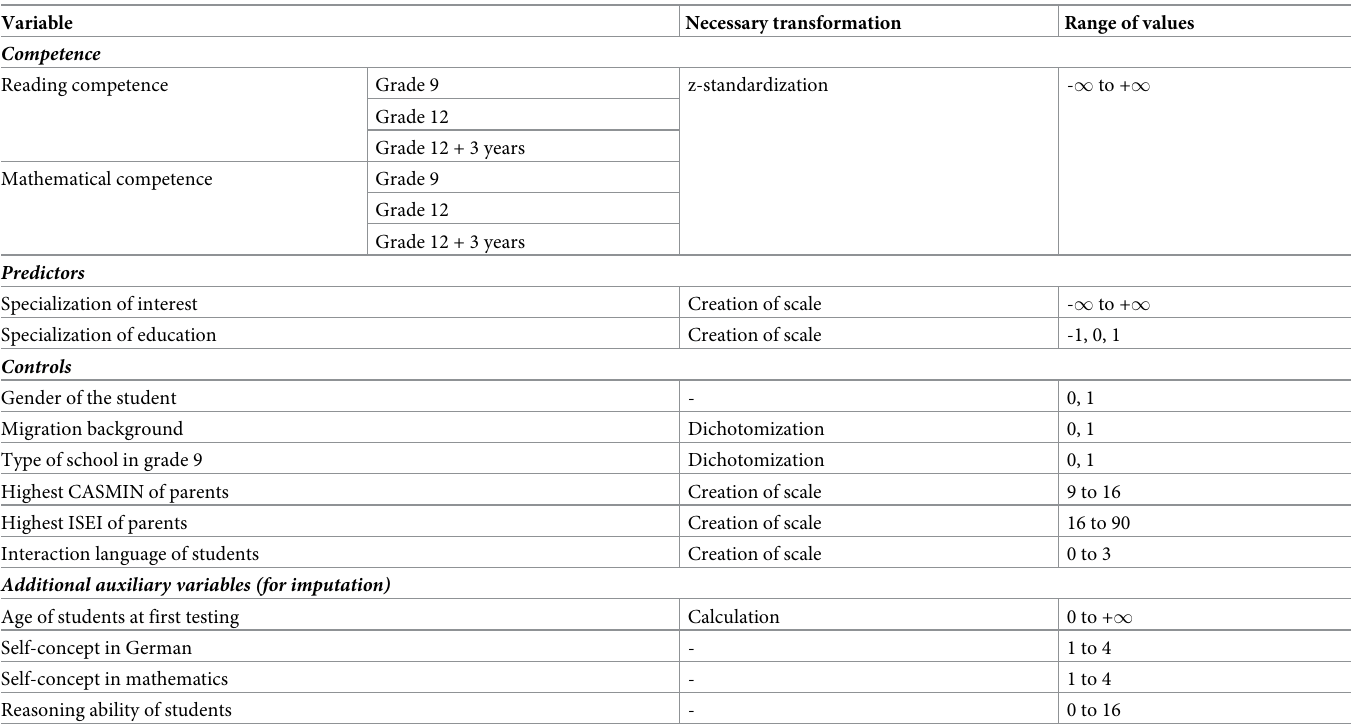
Table 1. List and description of all variables used in this